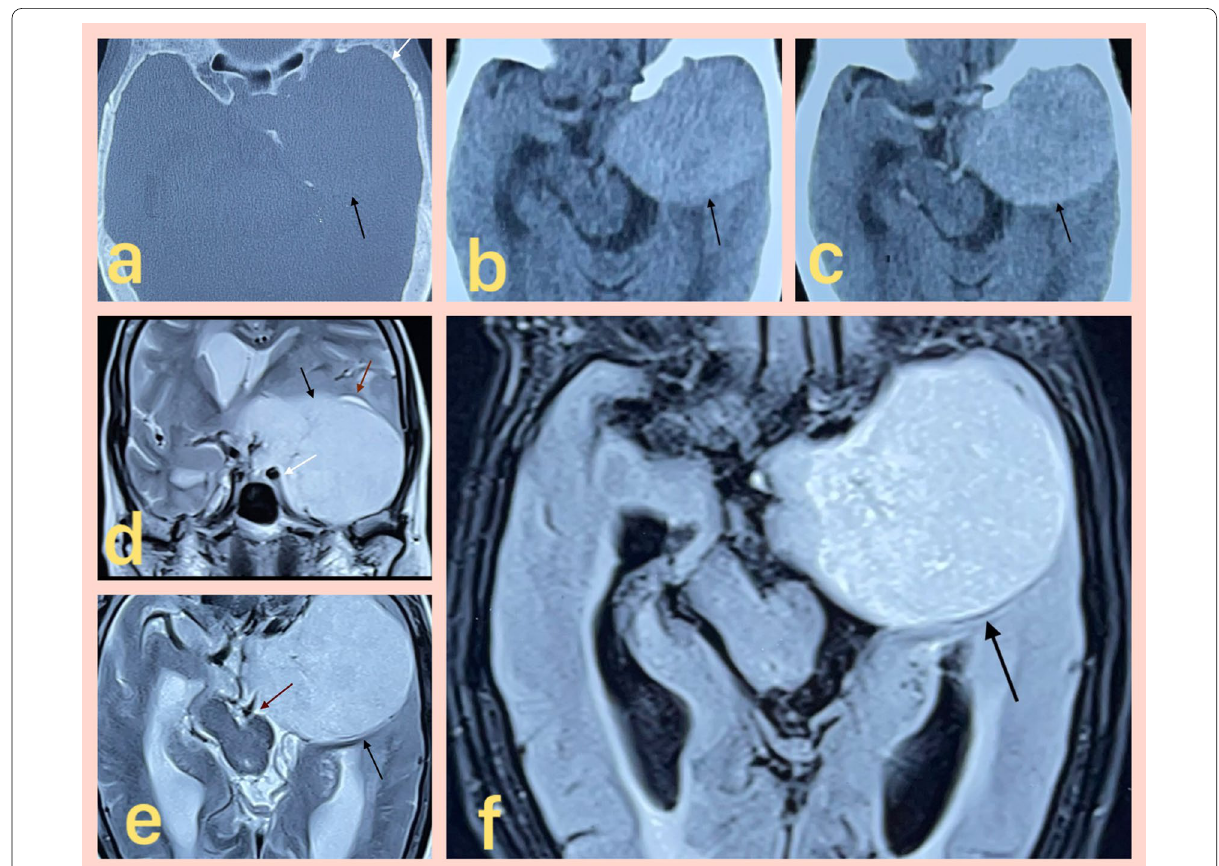
Fig. 1 a Axial non-contrast computed tomography (NCCT) image in bone window shows that the mass in the left parasellar region does not show calcification within and does show associated bony hyperostosis. b Non-contrast image showing homogeneously hyperdense mass with mass effect on left temporal lobes and left cerebral peduncle. c Post-contrast image showing homogenous post-contrast enhancement within the mass (denoted by black arrow). d Coronal T2-weighted image showing the extra-axial mass (denoted by black arrow) with encasement of cavernous ICA (denoted by white arrow) and CSF cleft sign (denoted by brown arrow). Axial T2WI ( e ) and FLAIR ( f ) images showing homogenously hyperintense mass (denoted by black